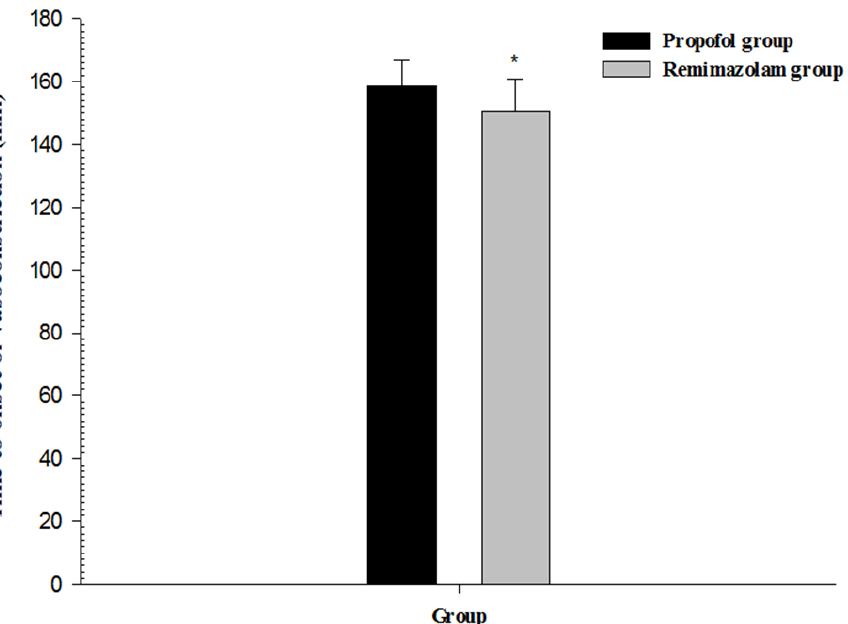
Figure 3. Time to onset of vasoconstriction after induction of general anesthesia with propofol or remimazolam; * p < 0.01 vs. propofol group.